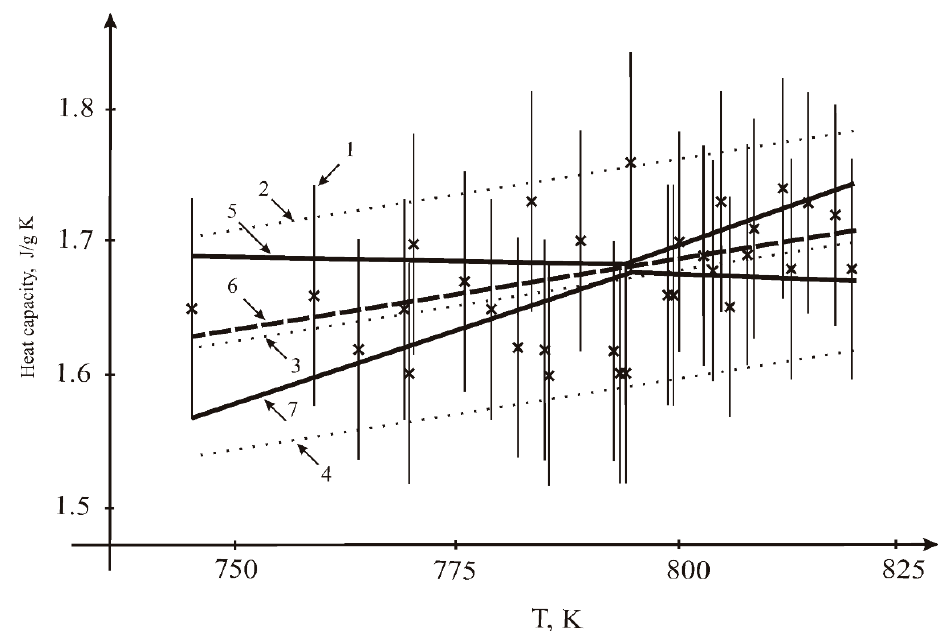
Figure 7. Results for fitting the heat capacity of the sample n = 31: 1 — measurements (×) and their uncertainty intervals; 2, 4 — range of admissible values according to LSQM (± 2σ); 3— dependence according to the LSM; 5, 7 — interval estimates of the upper and lower limits of the admissible values of the dependencies corridor; 6 — interval estimation of linear dependence.